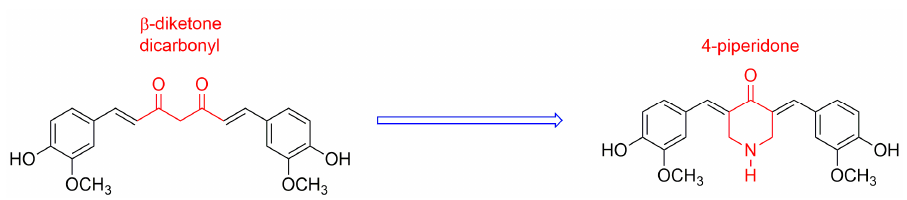
Figure 1. 4-piperidone structure derived from curcumin.